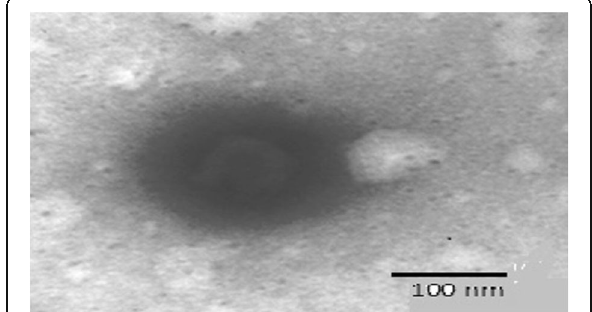
Fig. 3 TEM micrograph (21,000 X) of EV4 formulation